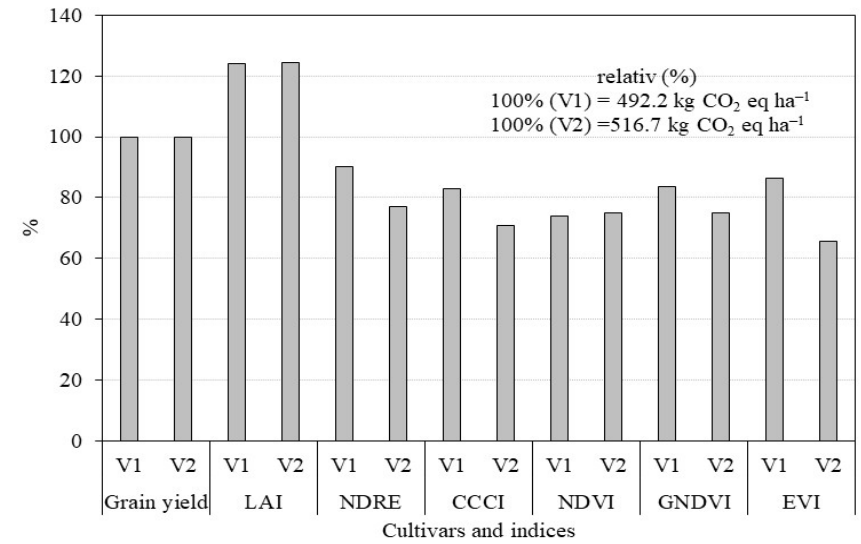
Figure 11. Simulation of reduction in GHG emissions from NPK fertilization depending on the index used in relation to the N dose resulting from the production function (grain yield). Genotype without (V1—wasko.gl − ) and with (V2—wasko.pg+) ω —gliadin